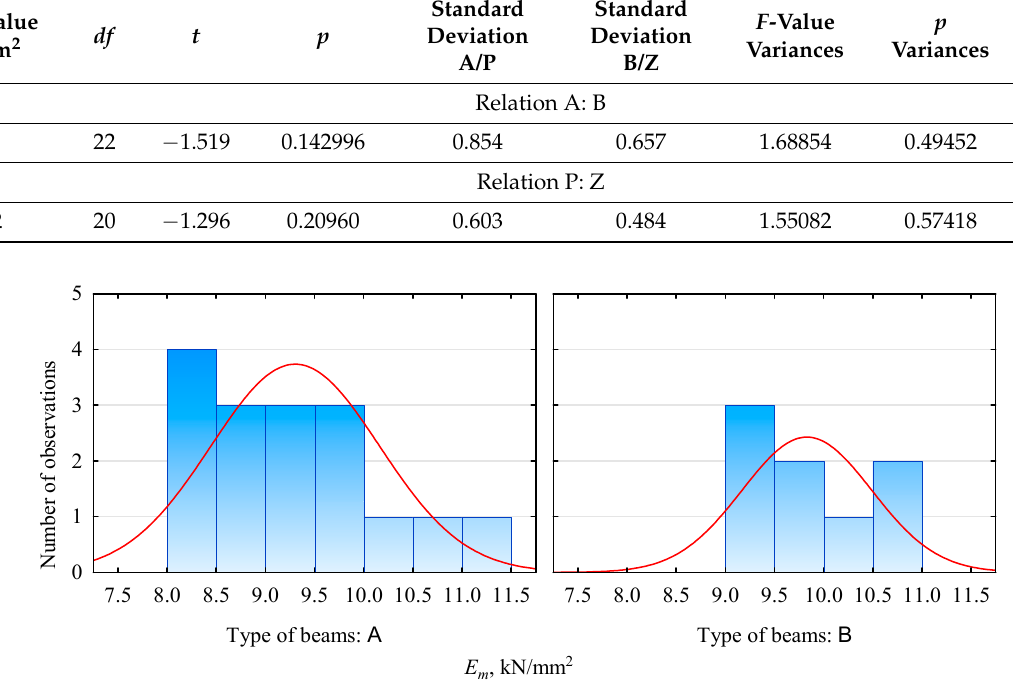
Figure 2. Modulus of elasticity distribution for beams manufactured with plywood face.